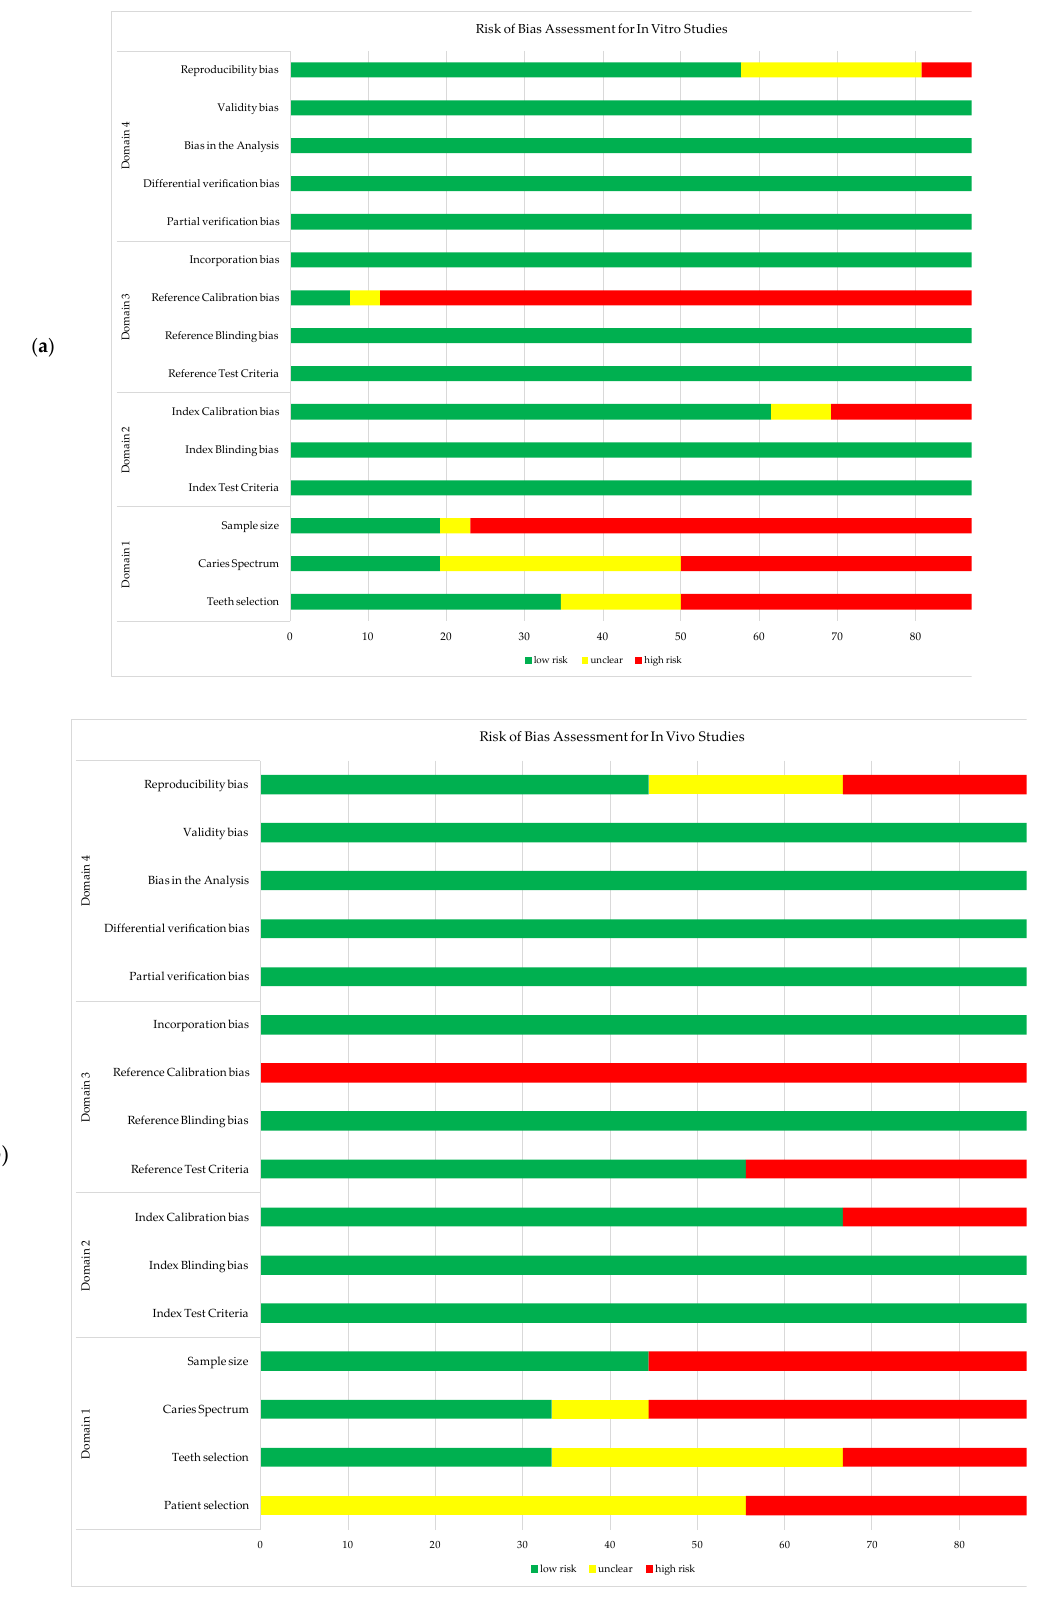
Figure 2. Risk of bias assessment for the studies include in meta-analysis: ( a ) in vivo studies; ( b ) in vitro studies.